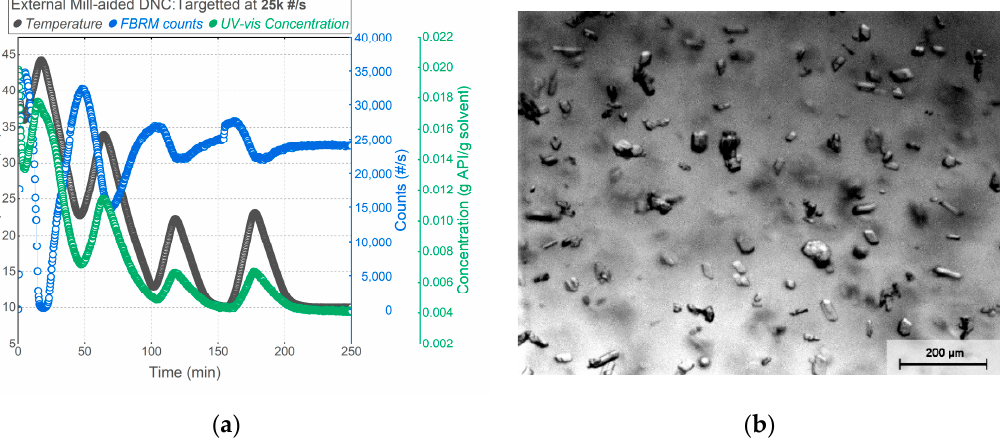
Figure 5. ( a ) Temperature ― , FBRM counts ― , and concentration ― profiles for experiment EMDNC-1 with final target counts of 25,000 #/s, and ( b ) PVM image of final product crystals of EMDNC.